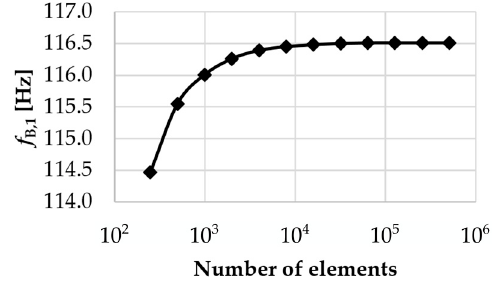
Figure 3. Mesh convergence